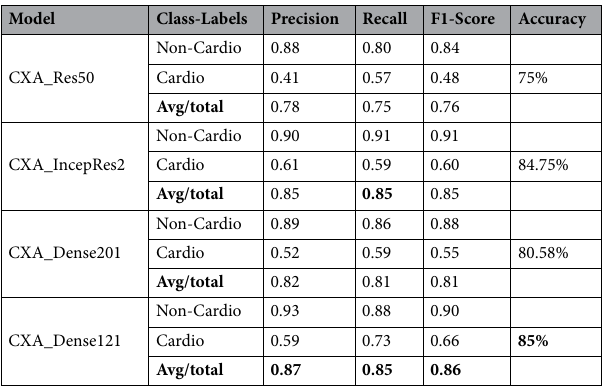
Table 4. Classification report on the test datasets from four models. Significant values are in bold. Precision, recall, f1-score of each model for both classes: non-cardiomegaly and cardiomegaly (cardio) along with the corresponding test accuracy.